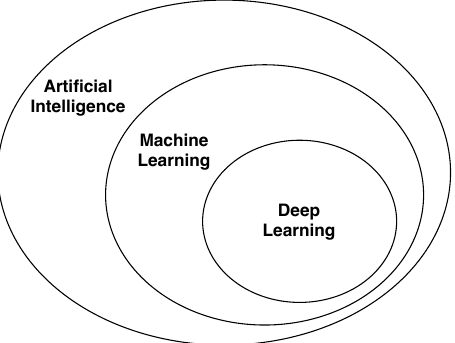
Figure 1. Overview of Artificial Intelligence. In modern-day practice, Deep Learning (DL) and Machine Learning (ML) are commonly referred to as Artificial Intelligence (AI), even though AI also includes rule-based simpler techniques. In this paper, the term AI refers to ML and